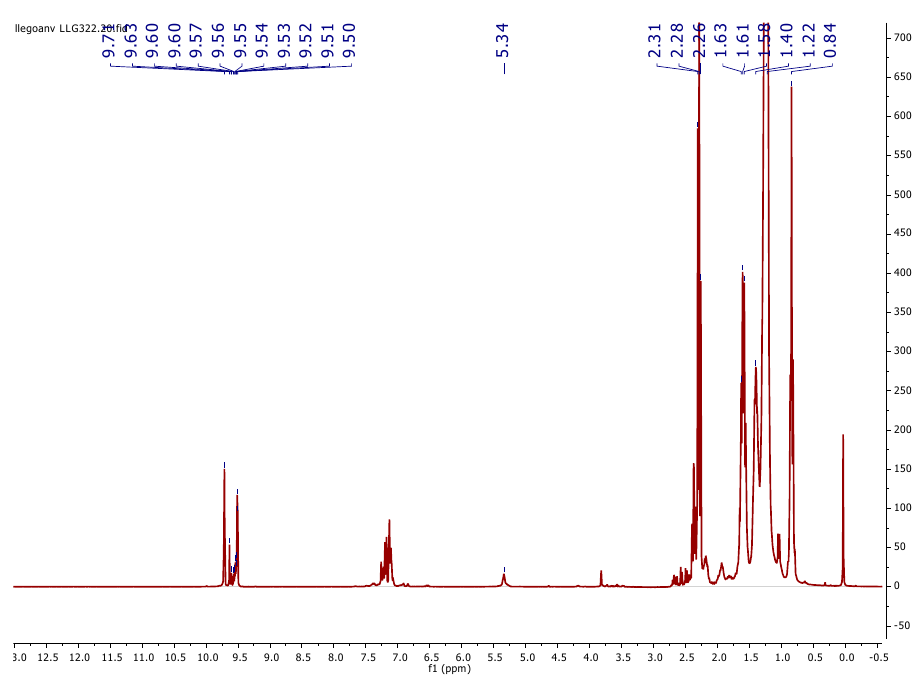
Figure A1. 1 H NMR spectrum (400 MHz, CDCl 3 , 298 K) of starting oleonitrile material furnished by Arkema Company.